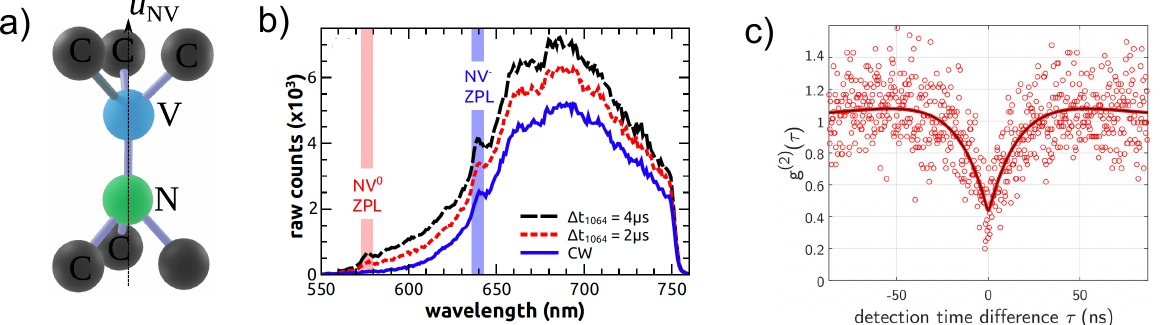
Figure 2. ( a ) Schematic of the crystalline structure of NV defect in diamond. The axis N − V is the quantization axis. ( b ) Pho- toluminescence from NV − centers in an optical tweezer using three different excitation conditions. Adapted with permission from [65]. © The Optical Society. ( c ) Autocorrelation function of photon emission from a single NV − center in a nanodiamond levitated in a Paul trap. Adapted with permission from [34]. Copyright 2020 American Chemical